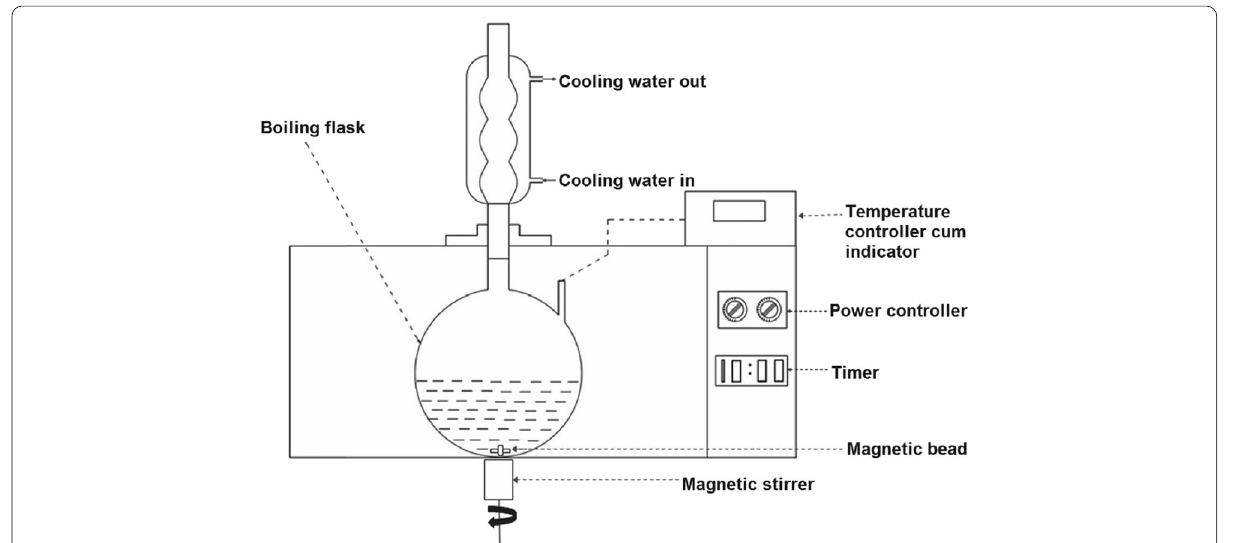
Fig. 4 MAE process where the flask is housed in the microwave oven (Krishnan and Rajan 2017). Placing the flask containing the sample in the microwave, attached to a condenser outside of microwave to capture the solution of interest compounds after